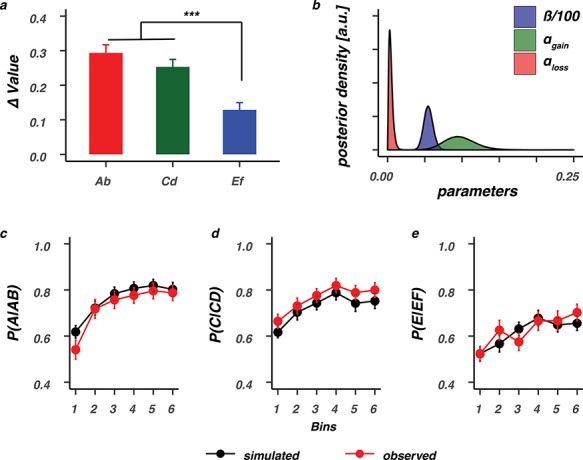
Value differentiation and model performance. (a) Value differentiation (\documentclass[12pt]{minimal}
\usepackage{amsmath}
\usepackage{wasysym} 
\usepackage{amsfonts} 
\usepackage{amssymb} 
\usepackage{amsbsy}
\usepackage{upgreek}
\usepackage{mathrsfs}
\setlength{\oddsidemargin}{-69pt}
\begin{document}
}{}$\varDelta$\end{document}Value) for the selection of the optimal (A, C, E) stimuli over the suboptimal (B, D, F) stimuli decreased as a function of feedback reliability and was smallest for the most uncertain EF stimuli. ***P < 0.0001, Bonferroni corrected. (b) Group-level posteriors for all \documentclass[12pt]{minimal}
\usepackage{amsmath}
\usepackage{wasysym} 
\usepackage{amsfonts} 
\usepackage{amssymb} 
\usepackage{amsbsy}
\usepackage{upgreek}
\usepackage{mathrsfs}
\setlength{\oddsidemargin}{-69pt}
\begin{document}
}{}$Q$\end{document}-learning parameters. The bottom row shows model performance, where data were simulated with the estimated individual subject parameters and evaluated against the observed data for the AB (c), CD (d), or EF (e) pairs. Bins contain ±16 trials. Error bars represent standard error of the mean.